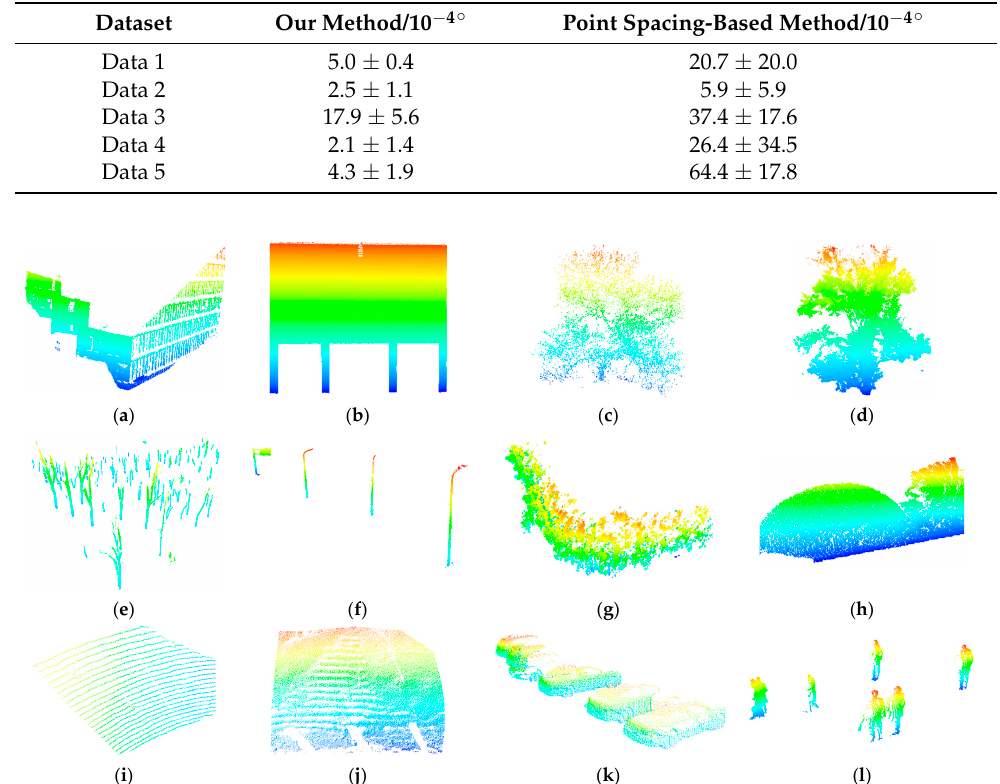
Figure 9. Different types of targets were selected from the five datasets. ( a ) building 1 with a large range of incident angle variation, ( b ) building 2 nearly perpendicular to the laser beam, ( c ) crown 1 of a small arbor, ( d ) crown 2 of a tall arbor, ( e ) pole 1 (stem), ( f ) pole 2 (street lamp and traffic sign), ( g ) shrub 1, ( h ) shrub 2, ( i ) ground 1: man-made ground with a large incident angle, ( j ) ground 2: natural ground on a slope, ( k ) car, ( l ) pedestrian.